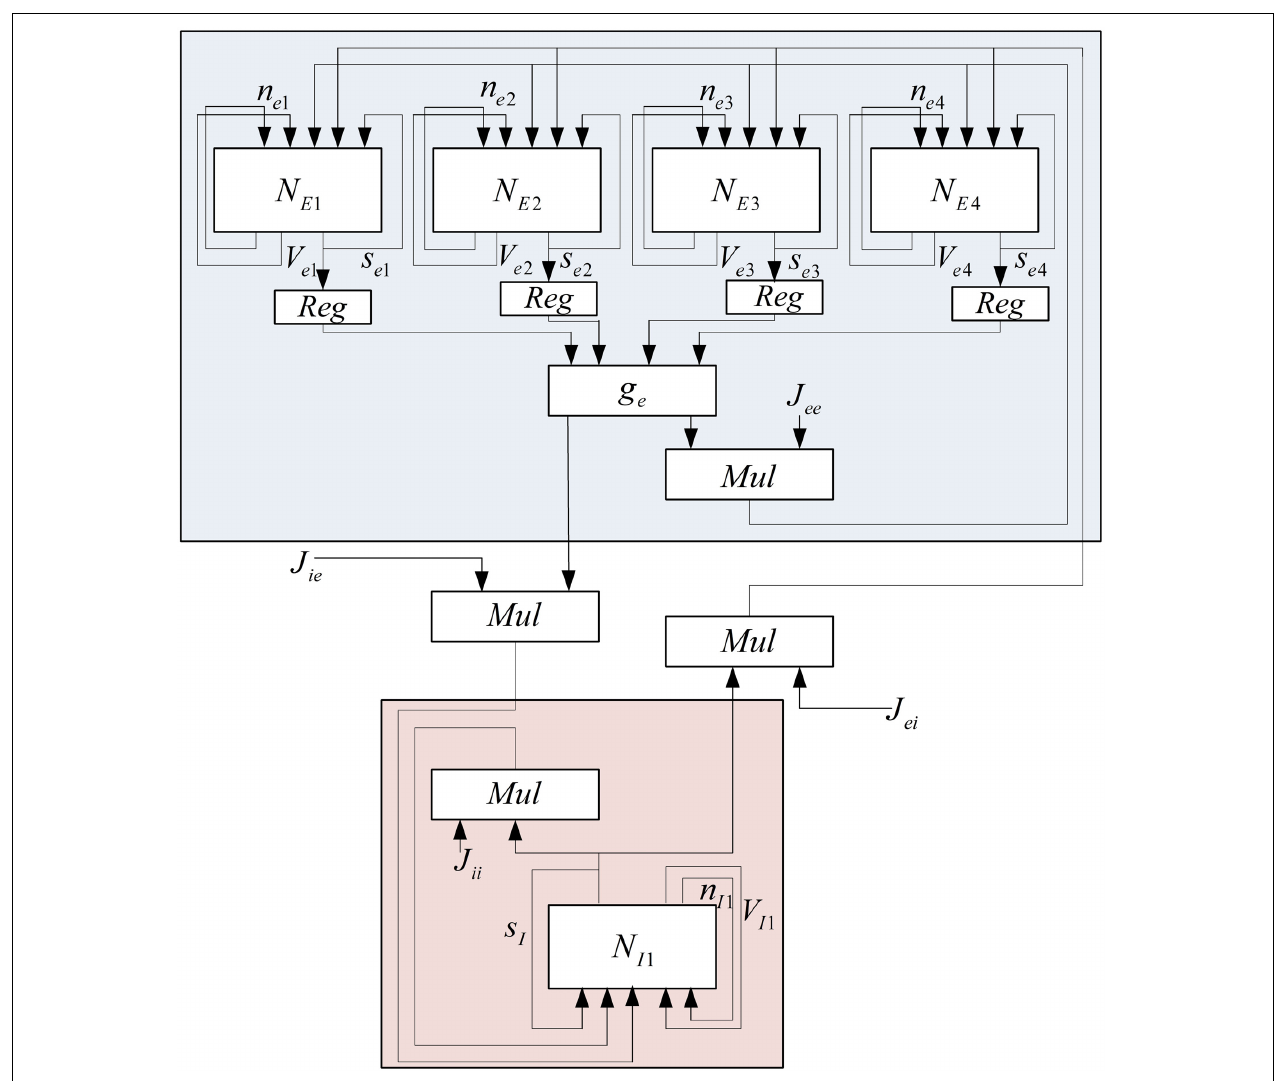
FIGURE 5 | Block diagram of implemented mini-column with five